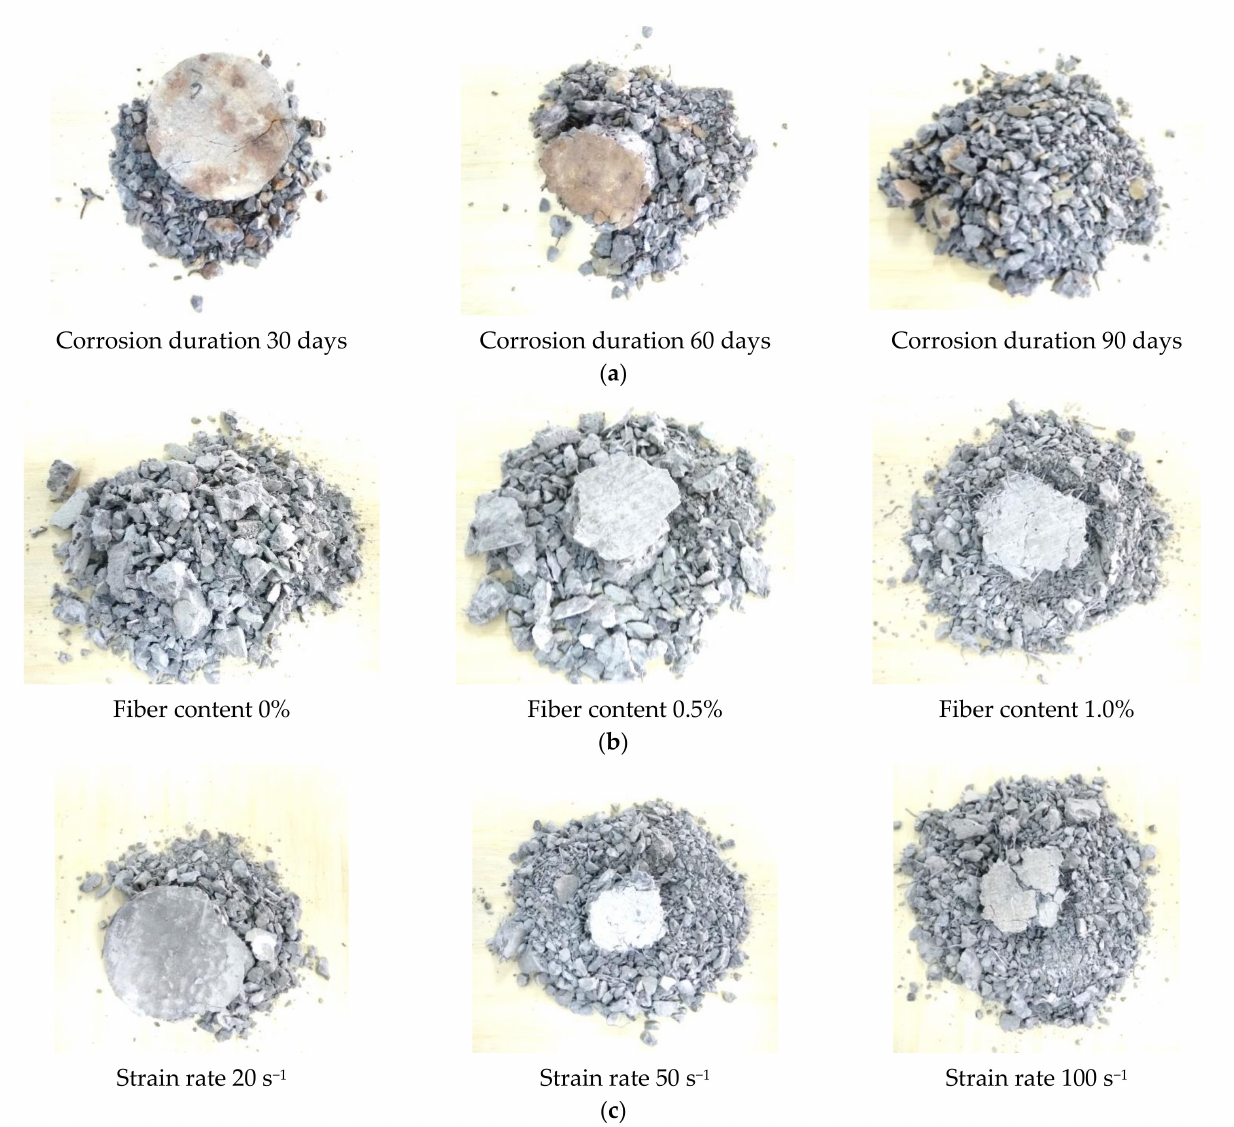
Figure 4. Fragmentation of the concrete samples, ( a ) strain rate = 20 s − 1 , steel fiber content = 1.0% under different corrosion durations. ( b ) strain rate = 20 s − 1 , corrosion duration = 0 days with different with different fiber content. ( c ) corrosion duration = 0 d, fiber content = 0.5% under different strain